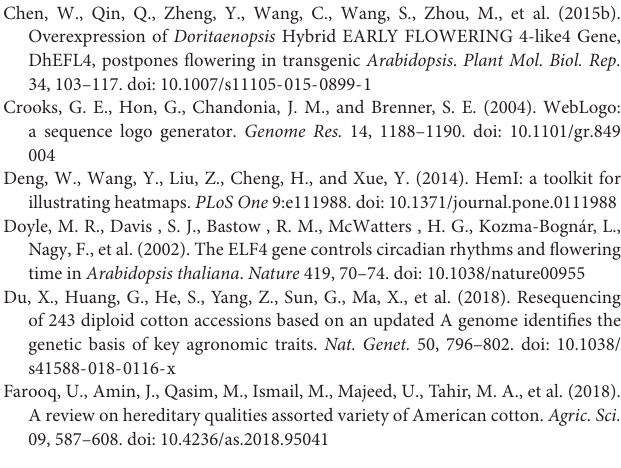
Supplementary Table 5 | Primer pairs used in the qRT-PCR analysis.